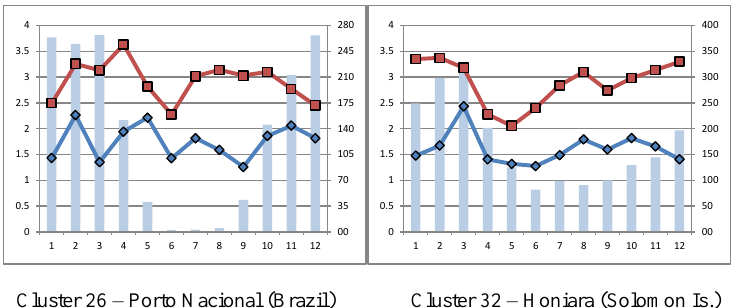
Cluster 26 – Porto Nacional (Brazil) Cluster 32 – Honiara (Solomon Is.) Fig. 8. Regression model ( δ 18 O) performance comparison based on RMSE (‰, left axis) of models M1 (red) versus M4 (blue) for amount- weighted monthly predictions for six climatic cluster centroids. Lower RMSE means better performance. Mean monthly precipitation amount (mmmonth − 1 , right axis) is shown by blue bars to indicate the timing of rainy and dry seasons. An ideal model would produce seasonally consistently low RMSE. That there were flatter monthly patterns and a lower RMSE of M4 compared to M1 shows improved seasonal predictive outcomes when using regionalized best-fit regressor